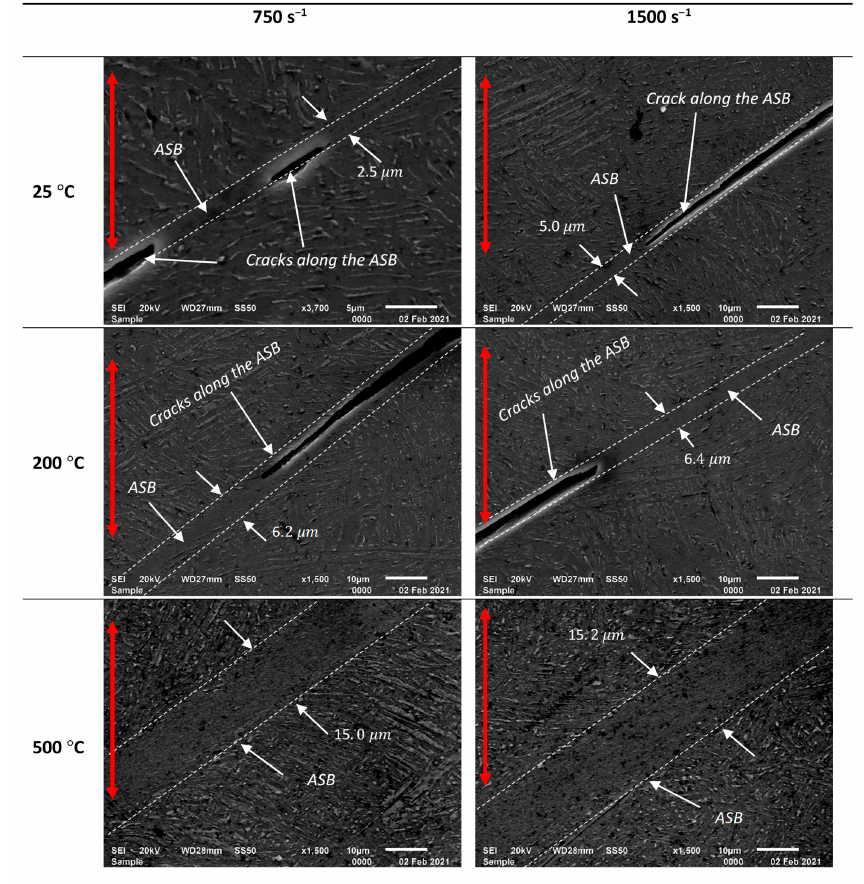
Figure 14. Secondary electron images showing adiabatic shear bands on sections of deformed surfaces of samples C at different strain rates and temperatures (note the different magnification at 750 s − 1 and 25 ° C). The red arrows indicate the compression loading axis.